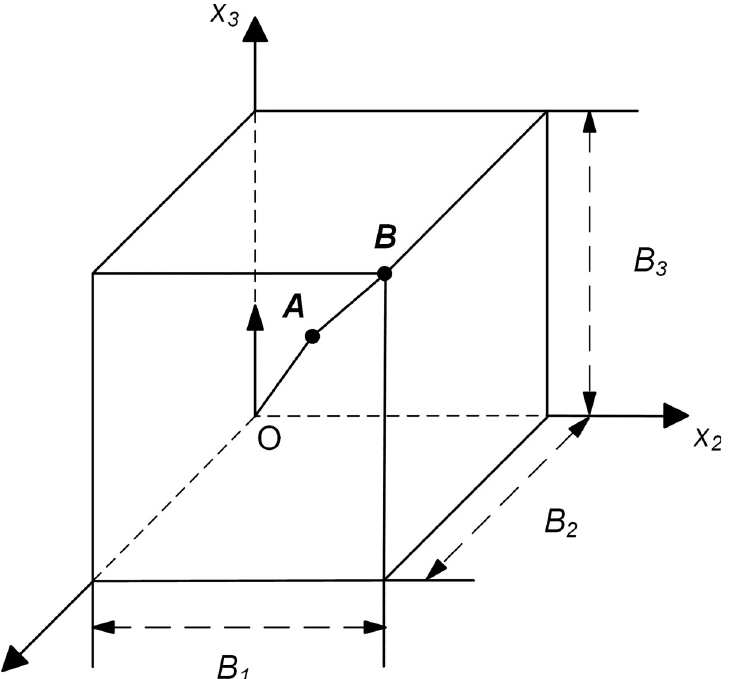
Fig 6. Computational domain in the wave source problem (Quadrant